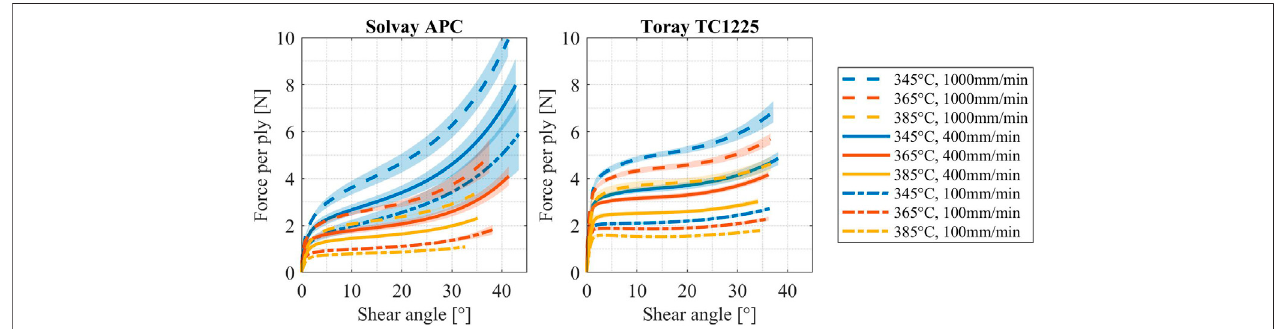
Figure 7 . The typical deformation for bias extension, according to